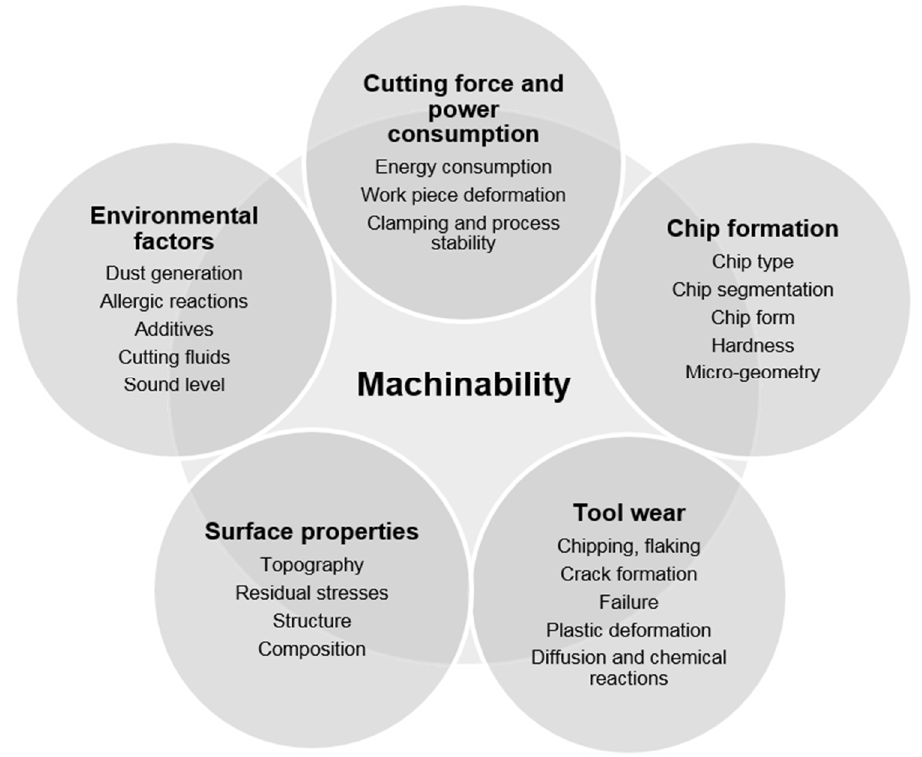
Figure 2. A schematic illustration of the overall parameters that is included in the complex machinability